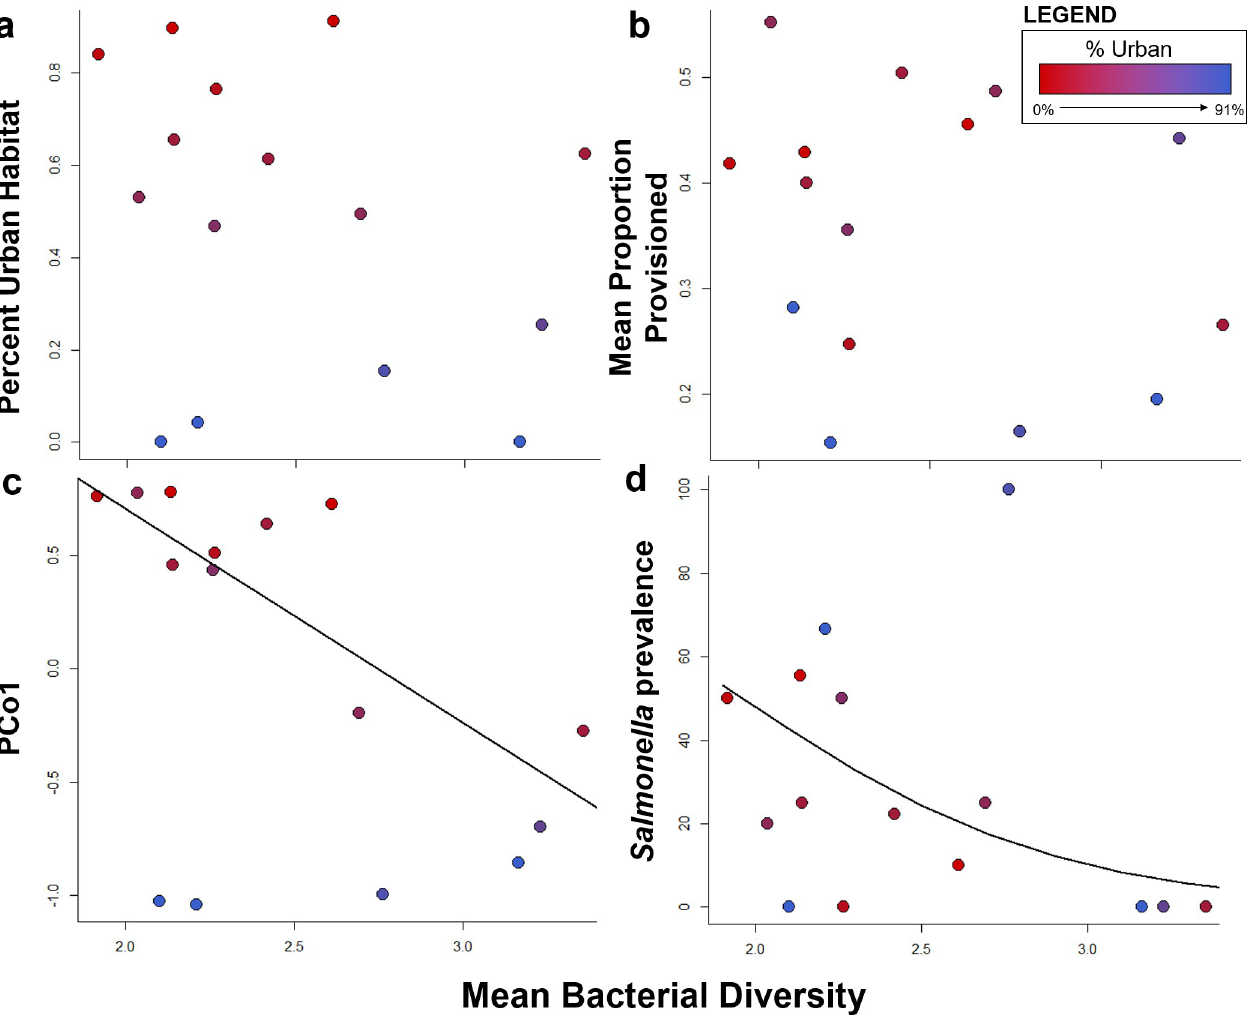
Fig 4. Correlation of bacterial diversity to urbanization (a), dietary provisioning (b), and bacterial community composition (c), and Salmonella prevalence (d). Circles represent average values for 15 capture sites and colored along an urban gradient from red (most urban) to blue (least urban). Bacterial diversity was not significantly correlated to landscape and dietary factors but was significantly associated with overall community composition and Salmonella prevalence (see text for statistics).